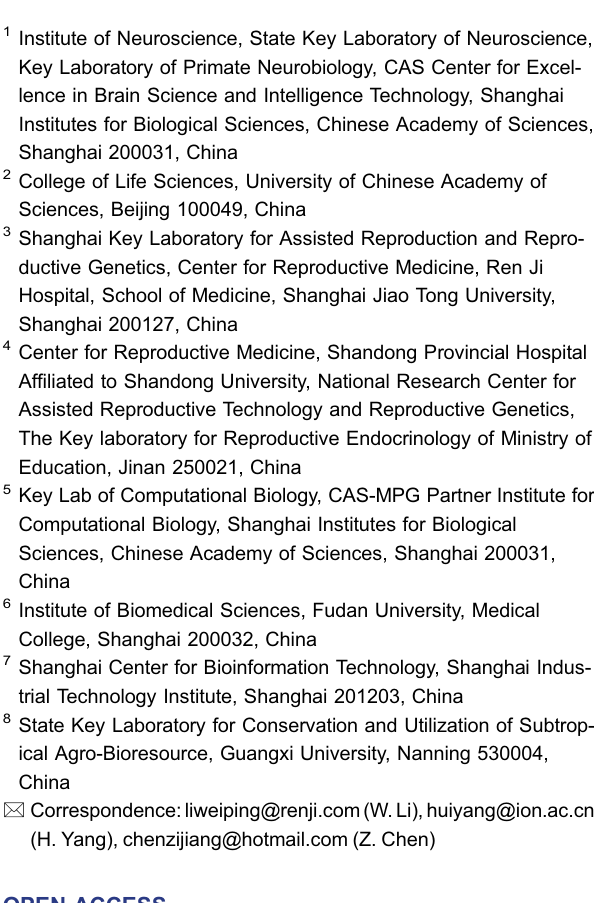
Figure 1. Base editing in human 3PN zygotes using BE3 and SaKKH-BE3 . (A) Schematic diagram showing the structure of BE3 and SaKKH-BE3. XTEN, a linker; UGI, uracil glycosy- lase inhibitor. (B) The target sequence at the HBB locus. The sgRNA sequencing and the PAM sequence are shown in black and blue, respectively. The nucleotide substituted by BE3- mediated base editing is shown in red. (C) Sanger sequencing chromatograms of DNA from wild-type and HBB -E1 mutant embryo. The red arrow indicates the substituted nucleotide. The relevant codon identities at the target site are shown under the DNA sequence. (D) Alignments of mutant sequences from embryos with BE3-mediated editing at the HBB locus. The target sequence is underlined. The substitutions and PAM site are shown in red and blue, respectively. The column on the right indicates the percent of relevant genotype in total sequencing reads. Wt, wild-type. (E) The target sequence at the FANCF locus. The nucleotide substituted by SaKKH-BE3-mediated base editing is shown in red. (F) Sanger sequencing chro- l matograms of DNA from wild-type and FANCF -E16 mutant e C embryo. (G) Alignments of mutant sequences from embryos with SaKKH-BE3-mediated editing at the FANCF locus. (H) The target sequence at the DNMT3B locus. The nucleotide substi- tuted by SaKKH-BE3-mediated base editing is shown in red. i e (I) Sanger sequencing chromatograms of DNA from wild-type t o and DNMT3B -E4 mutant embryo. (J) Alignments of mutant r sequences from embryos with SaKKH-BE3-mediated editing at P the DNMT3B locus. (K) Summary of base editing by BE3 and SaKKH-BE3 in human 3PN zygotes.